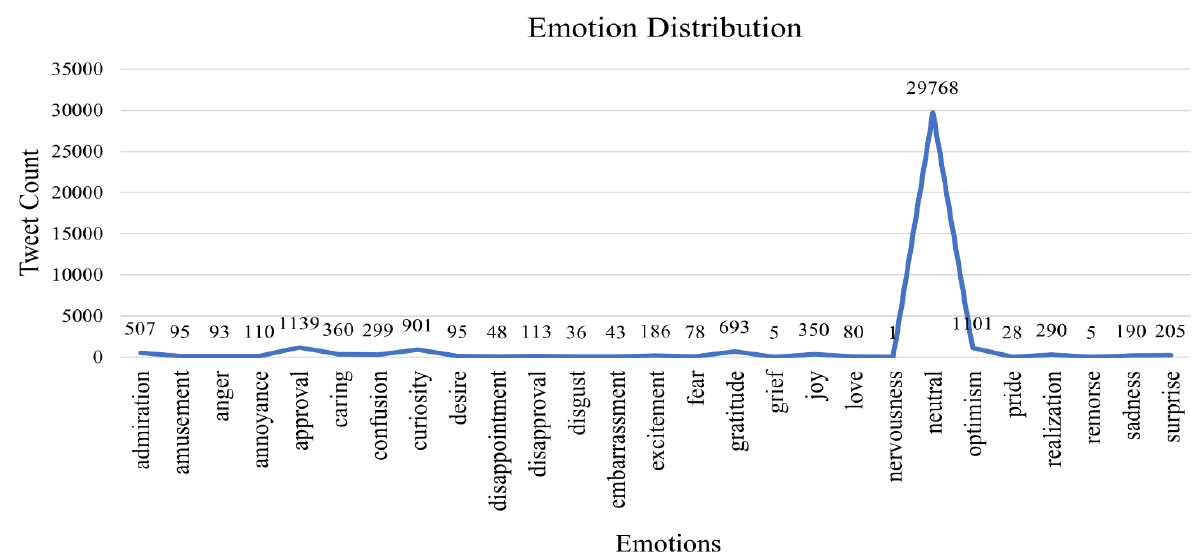
Figure 6. Distribution of 27 emotions according to the number of tweet count after emotion extraction from Emoroberta.